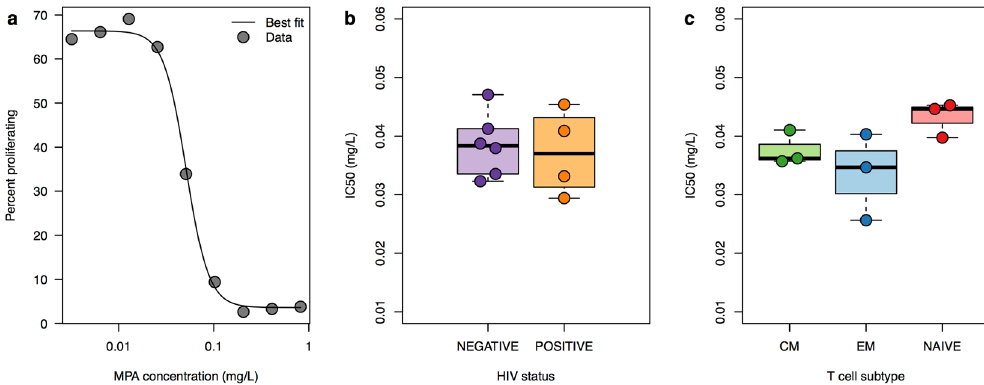
Figure 6. MMF pharmacodynamics. Pure mycophenolic acid (MPA) was added to CEM cells at varying concentrations and proliferation of CEM cells was measured to determine a dose-response curve and Hill slope. CD4 + T cells from stored peripheral blood mononuclear cell samples from 10 participants (4 HIV-infected, 6 HIV-uninfected) were stimulated to proliferate. CD4 + T cells from 3 HIV-negative subjects were sorted into effector memory (EM), central memory (CM), and naïve subsets. Pure MPA was added to these cells at varying concentrations in order to determine IC50s for MPA. ( a ) Dose-response curve with percentages of CEM cells proliferating at varying doses of MPA. The Hill slope is − 3.7. ( b ) 4 samples from HIV-positive participants and 6 samples from HIV-negative participants had similar IC50s. ( c ) IC50s were similar among CD4 + effector memory (EM), central memory (CM), and naïve T cell